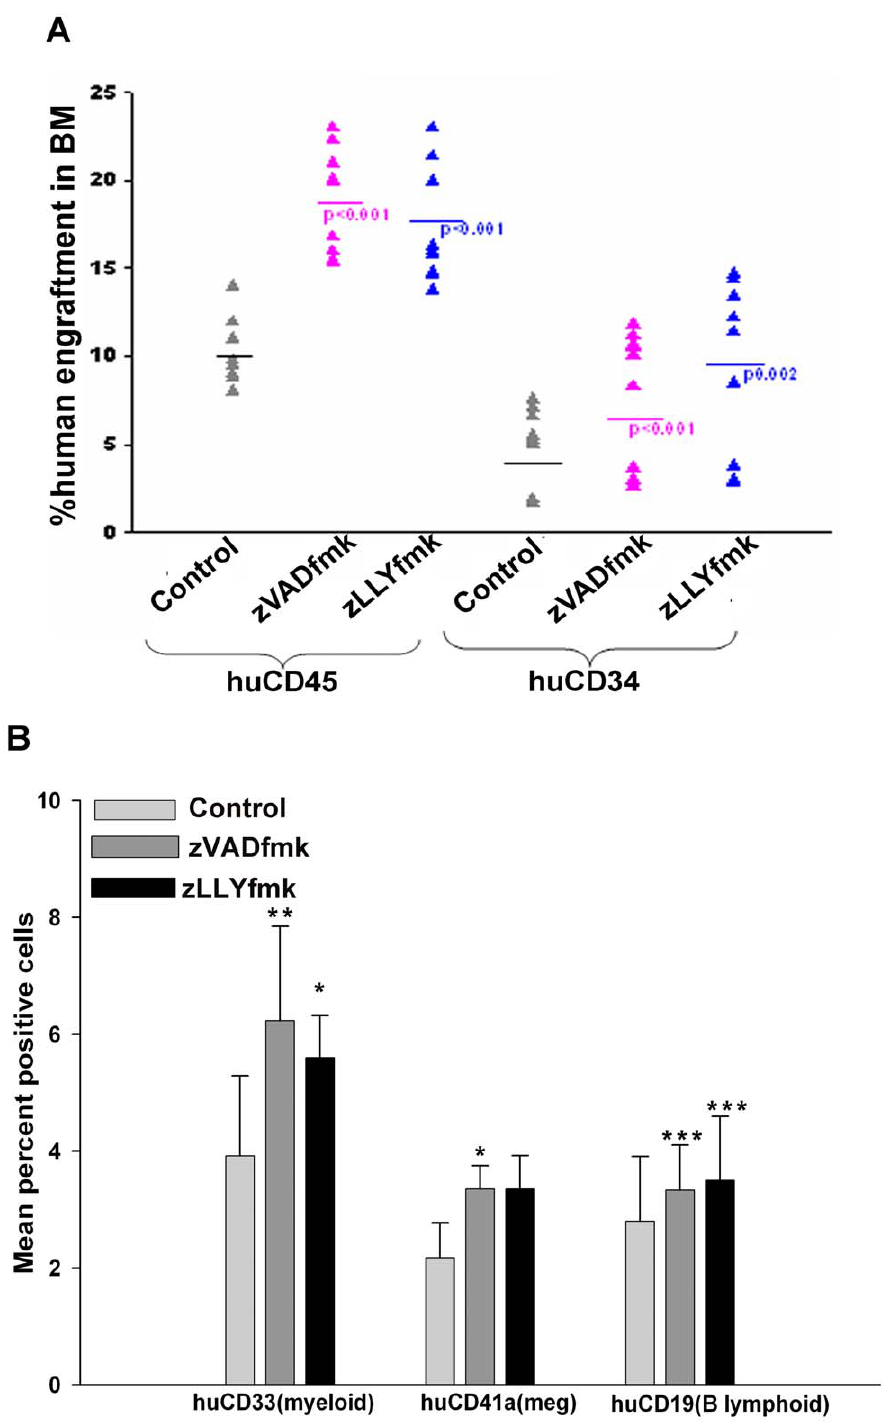
Figure 5. In vivo engraftment of the expanded HSPCs in NOD/SCID mice. (A) The SRC (Scid Repopulating Cells) efficiency of the cultured HSPCs was assessed in NOD/SCID mouse model. The expanded cells were intravenously administered to the sub lethally irradiated recipient. After 16th week (4 months), the animals were sacrificed and the bone marrow cells were stained for human pan leukocyte marker CD45 and progenitor marker CD34. The presence of zVADfmk/zLLYfmk in the expansion culture proved to be more efficient in repopulating the marrow compared to the control as there was a significantly higher engraftment detected by huCD45 and huCD34 (B) Multilineage engraftment potential of the zVADfmk/ zLLYfmk expanded cells was superior to their control counterparts as detected from the presence of huCD33, huCD41a and huCD19 in the bone marrow of recipient mice. Data represented as mean 6 standard deviation (n=3).